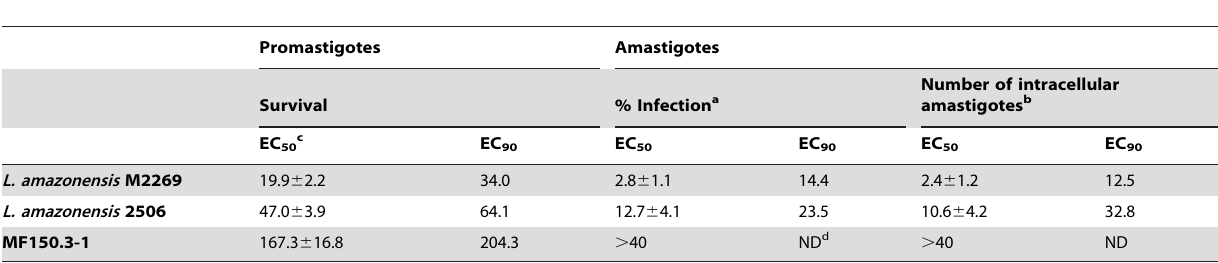
Table 1. Activity of MF against promastigotes and intracellular amastigotes of L. amazonensis wild-type strains and mutant MF150.3-1.